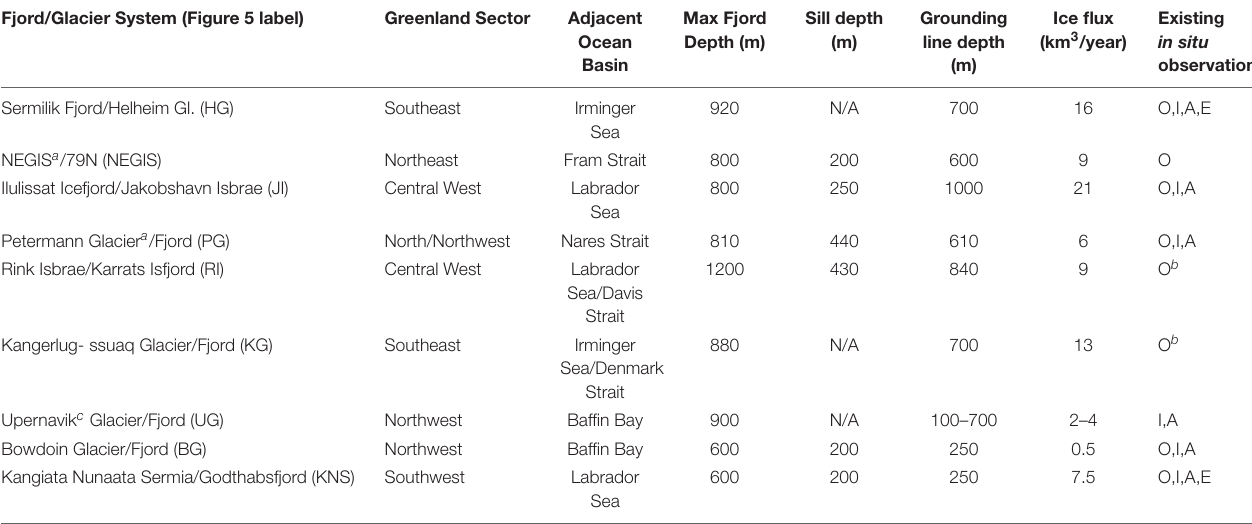
TABLE 2 | Characteristics of potential GrIOOS glacier-fjord sites, including the ocean basin adjacent to link to existing open ocean measurements, the fjord and glacier geometry to ensure a diversity of glacier/fjord types, Greenland sector, and whether in situ measurements of ocean (O), ice (I), atmosphere (A), and ecosystem (E) variables exist now or in the